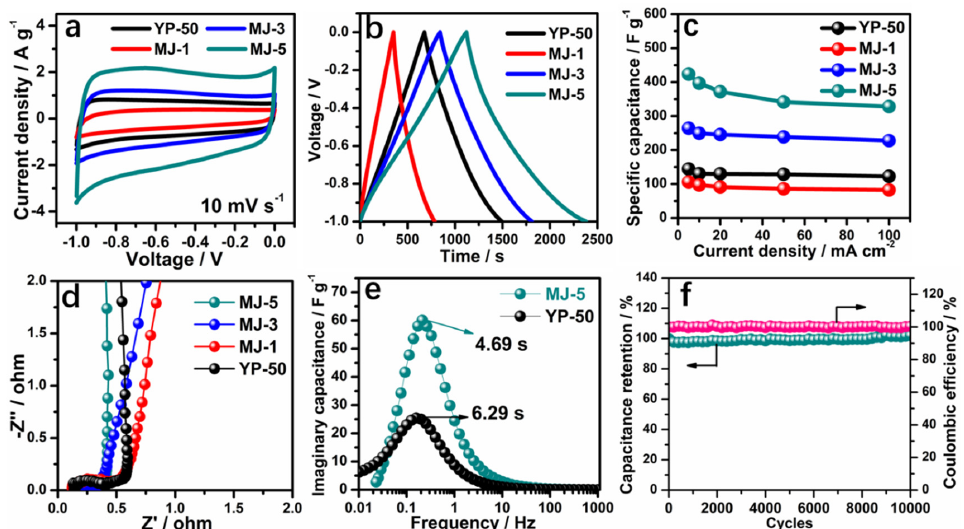
Figure 4. Electrochemical performance of MJ − x in 6 M KOH. ( a ) CV curves of MJ − x and YP − 50 at a scan rate of 10 mV s − 1 ; ( b ) GCD curves of MJ − x and YP − 50 at 5 mA cm − 2 ; ( c ) Rate performance of MJ − x and YP − 50; ( d ) Nyquist plots of MJ − x and YP − 50 [47]; ( e ) The normalized imaginary part of the capacitance versus frequency plots for MJ − 5 and YP − 50; ( f ) Cycling performance of MJ − 5 at 500 mA cm − 2 .